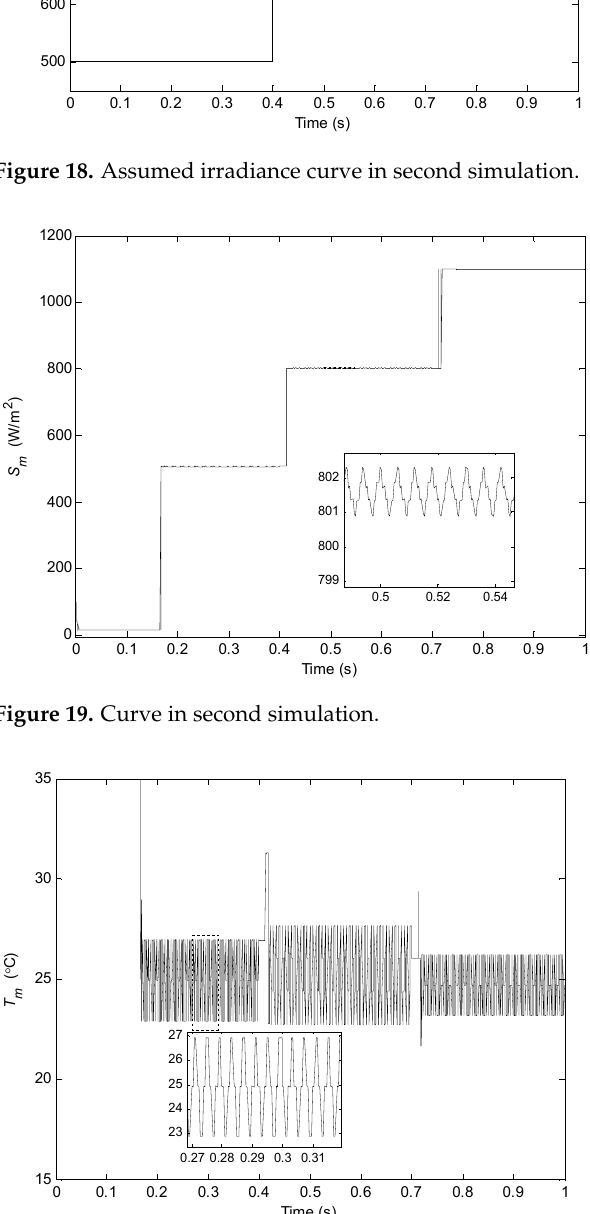
Figure 21. Curve in second simulation. Figure 22. I S  curves under increasing S conditions.